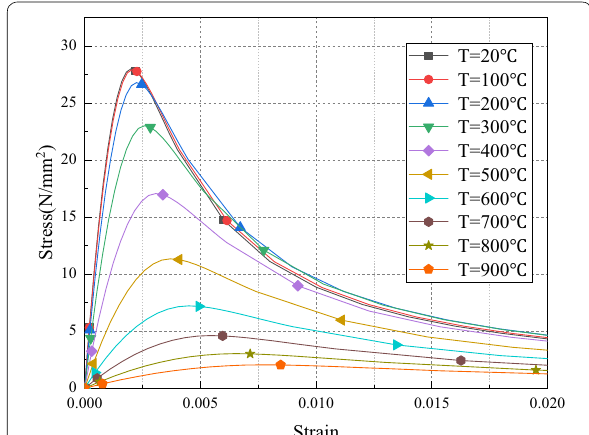
Fig. 13 Stress–strain curves of concrete at different temperature